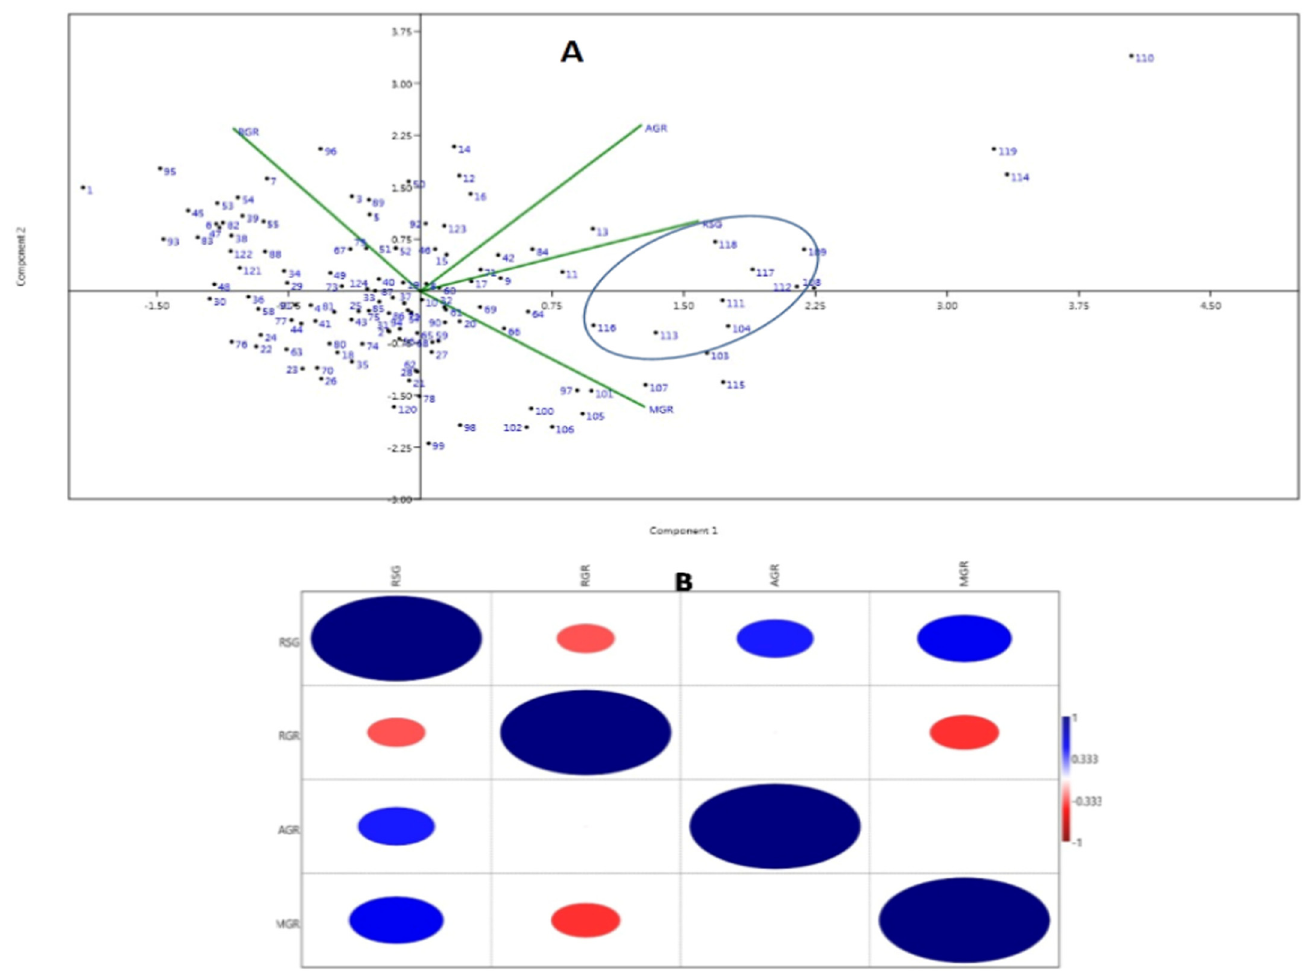
Figure 3. ( A ) Principal component analysis biplot diagram showing 124 landraces in two PCs for 4 seedling stage growth parameter. ( B ) Heat map showing Pearson’s correlation coefficients for the growth parameters. AGR: Absolute growth rate; MGR: mean germination rate; RGR: relative growth rate and RSG: rate of shoot growth. The numbers in the dot present in the diagram depict the serial numbers of the genotypes listed in Table 1. Significant correlations are colored either in red (negative correlation at 0.01 level) or blue (positive correlation at 0.01 level).